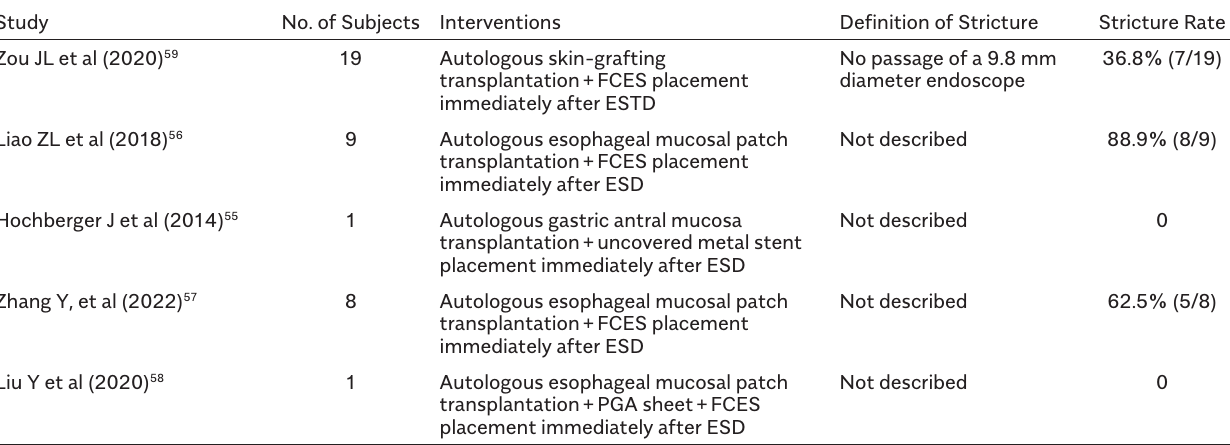
Table 4. Studies on Autologous Tissue Transplantation for Prevention of Esophageal Stricture After Whole Circumferential Endoscopic Resection